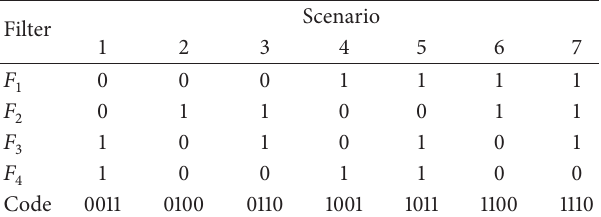
Table 1: Practicable filter